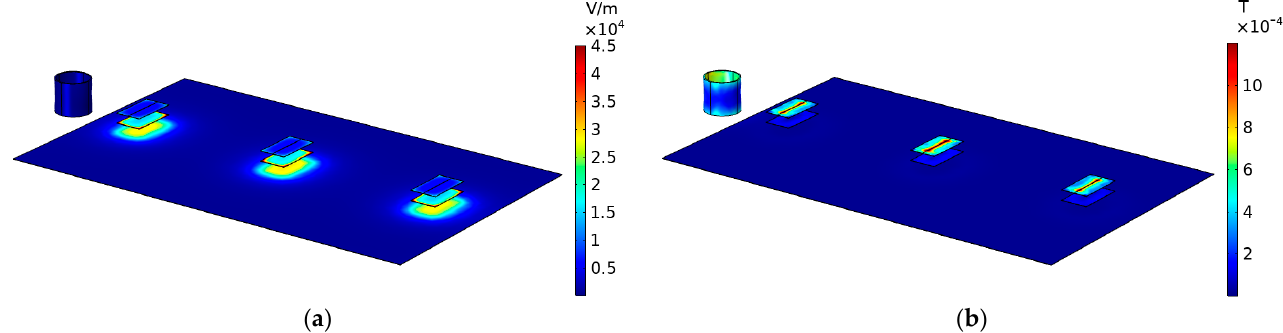
Figure 10. Electromagnetic field simulation of DWPT: ( a ) Electric field simulation; ( b ) Magnetic field simulation. A simulation diagram of electric field distribution in the vertical direction is shown in Figure 11. The electric field is concentratedly distributed near the coupling aluminum foil under the power receiving device and does not spread outward. When the system supplies power to low-power electrical equipment, the electric field strength in most areas around the desktop is relatively weak, and electromagnetic interference to electronic equipment near the desktop is relatively weak.